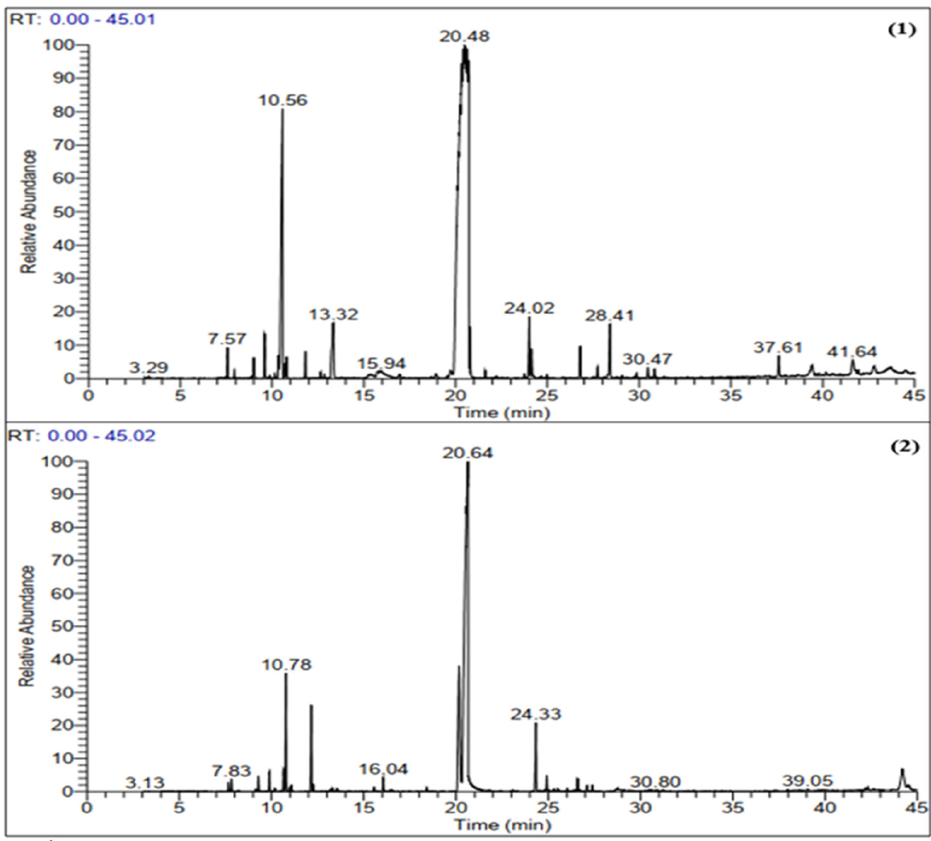
Figure 1. GC-MS chromatogram of T. capitatus ( 1 ) and T.broussonetii ( 2 ) EOs . Table 1. Chemical composition of T. capitatus and T. broussonetii EOs.